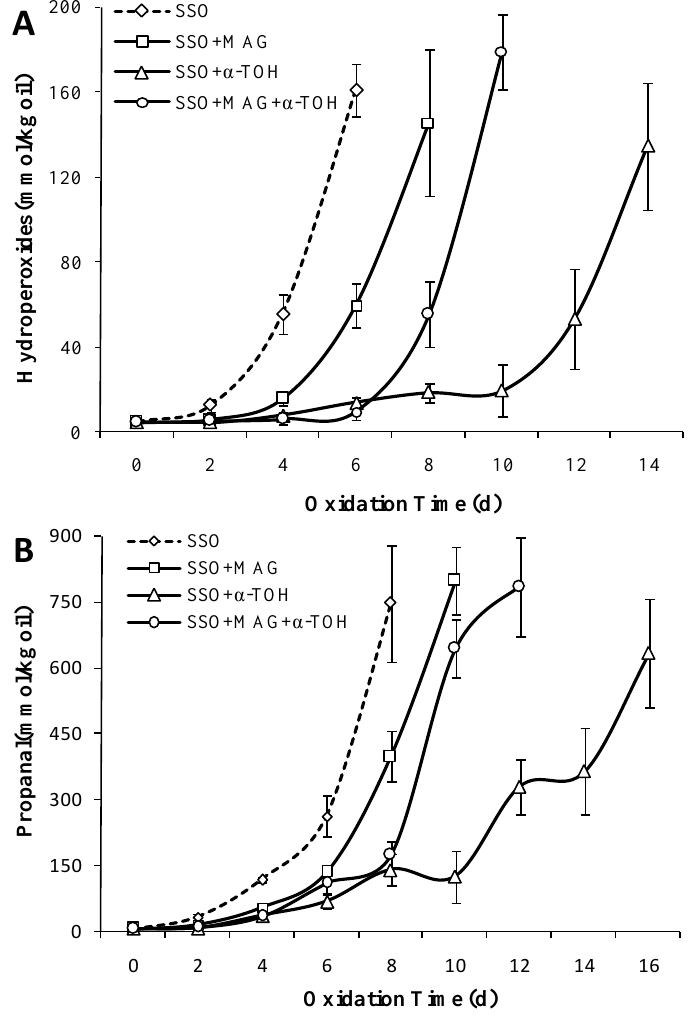
Figure 7. Effect of 2D-MAG structured lipids on the content of POV ( A ) and propanal ( B ) of stripped soybean oil with and without α-tocopherol (50 °C).